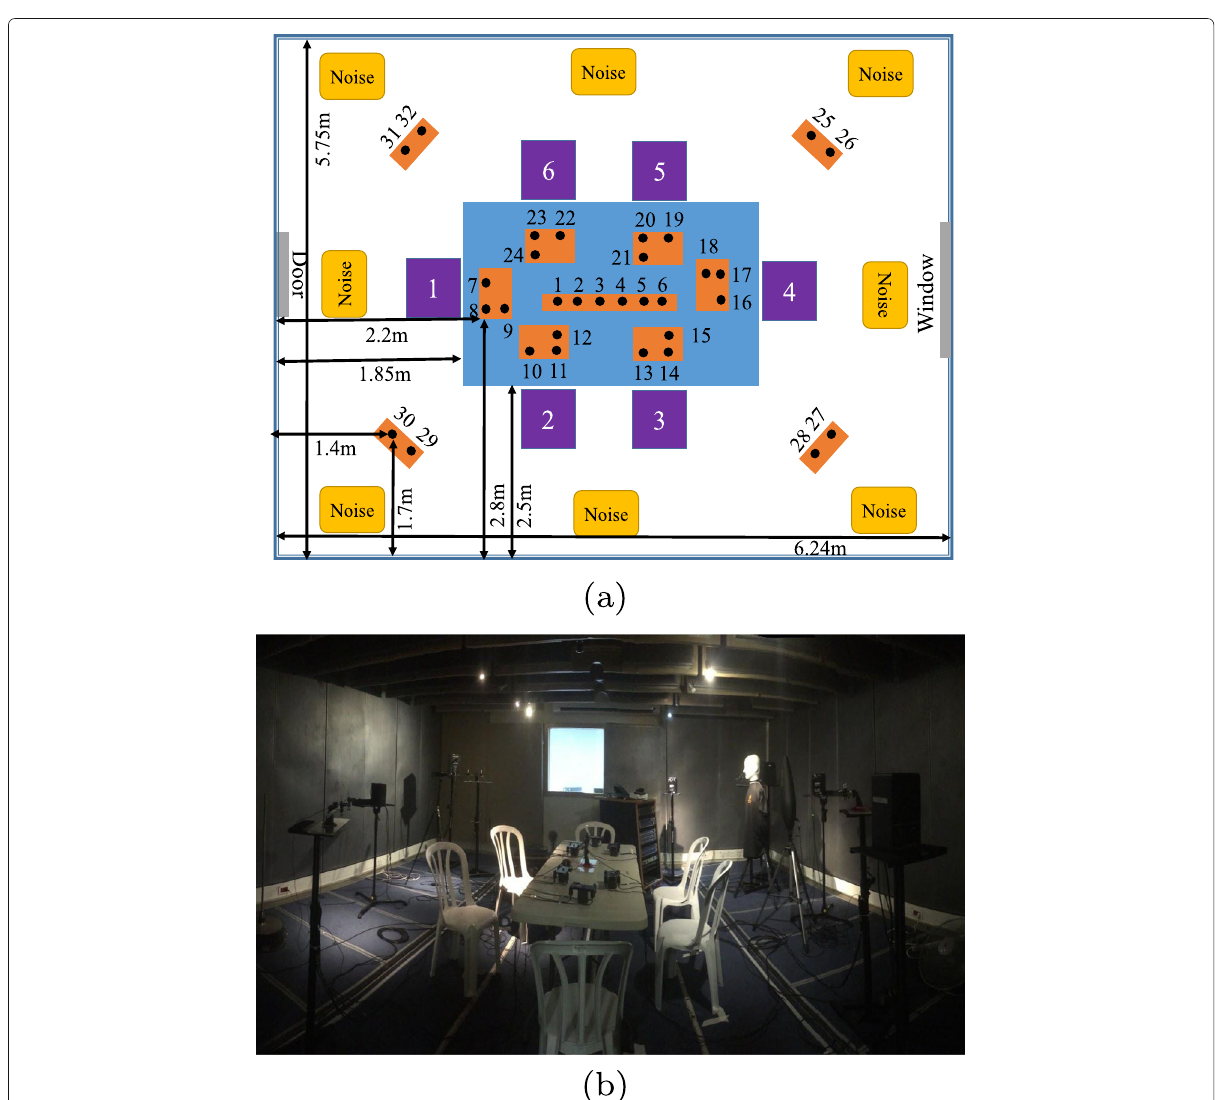
Fig. 3 a The room layout, containing a table (blue rectangle), 6 chairs where speakers are sitting (purple squares), 32 microphones (black circles), and 8 loudspeakers emitting noise (yellow rectangles). The microphones utilized for the presented experiments are 25–32 or 1–6. b A photo of the room setup of the experiments conducted at the BIU acoustic lab